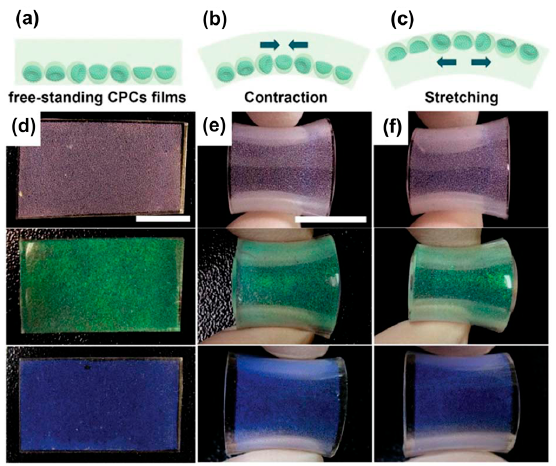
Figure 14. Optical microscopy images of patchy supraparticles assembled by EISA using differently- sized polystyrene (PS) latex microparticles in suspension droplets, thereby generating these highly light-diffracting “opal balls”. Reprinted with permission from [97] (p. 4266). Copyright 2008 Wiley.